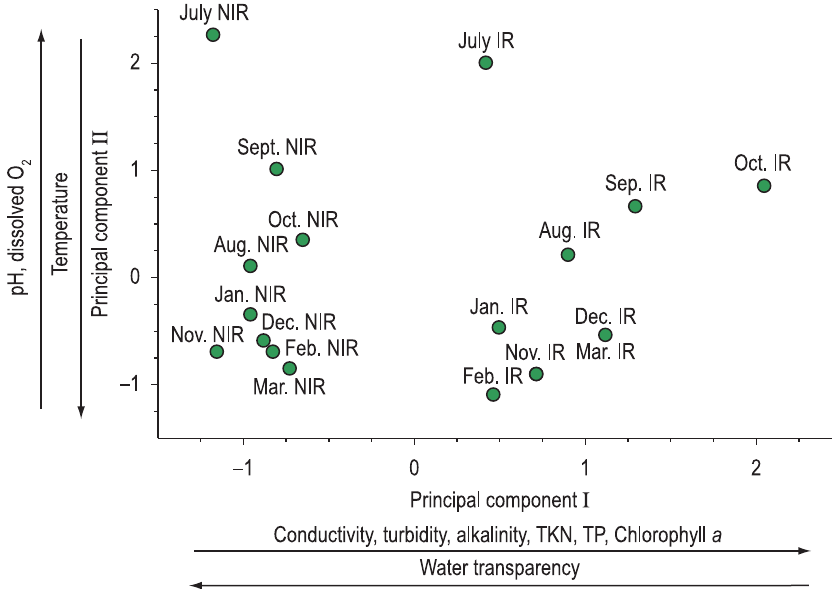
Figure 1. Ordination by Principal Components Analysis (PCA) of the collection months in the non-impacted reservoir (NIR) and the effluent-impacted reservoir (IR), based on the limnological variables analyzed. The two components explained 72.8% of the observed variation.